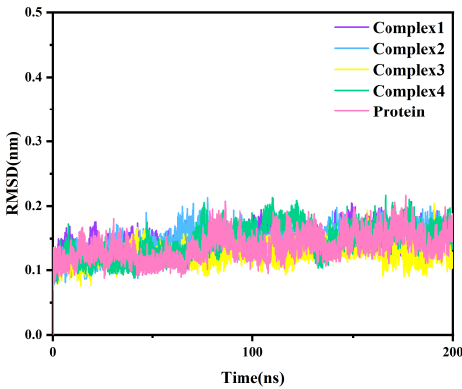
Figure 3. The RMSD of the Cα atomic backbone of the four complexes and independent protein with simulation time.